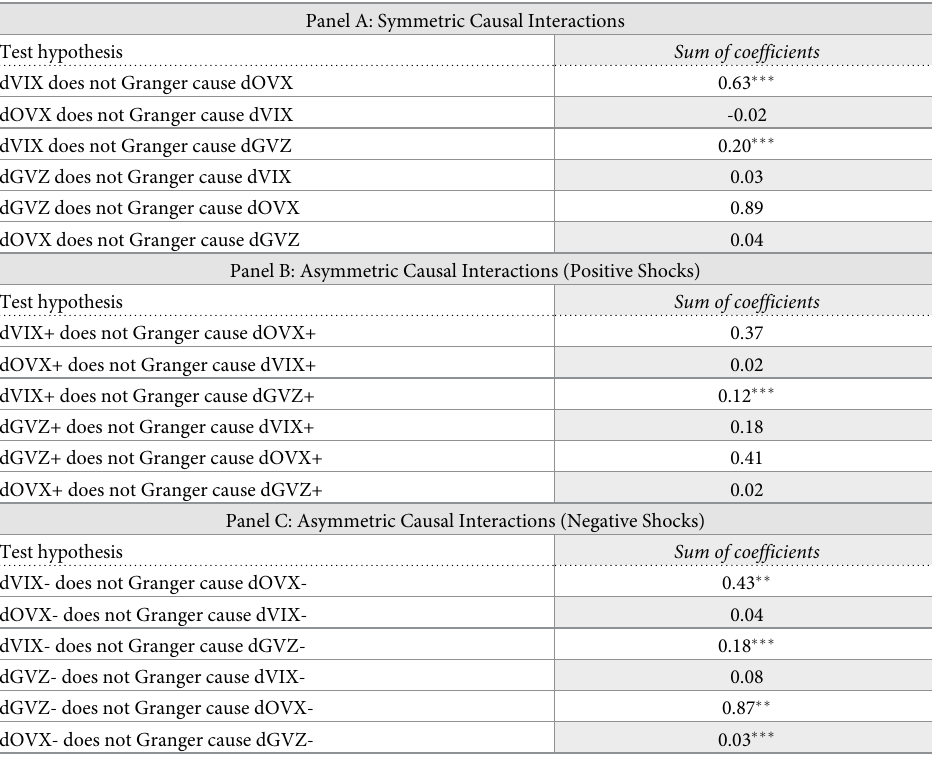
Table 3. Causality tests.